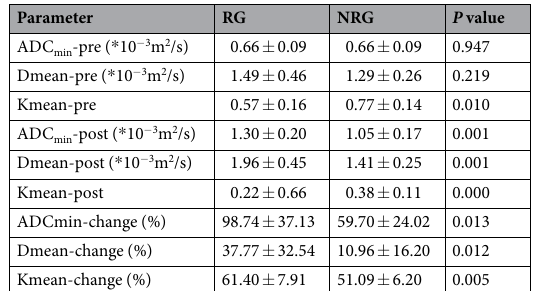
Table 1. Parameters Between Respond Group (RG) and No-respond Group